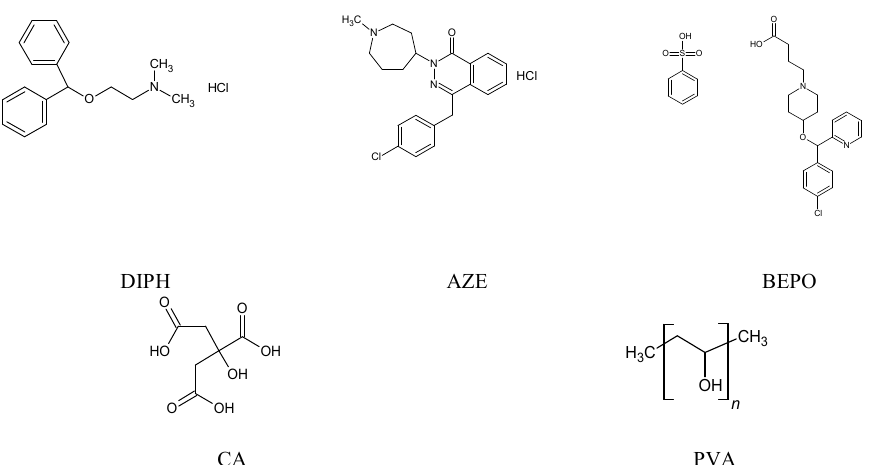
Figure 1. The chemical structures of diphenhydramine (DIPH), azelastine (AZE), bepotastine (BEPO), citric acid (CA) and polyvinyl alcohol (PVA).